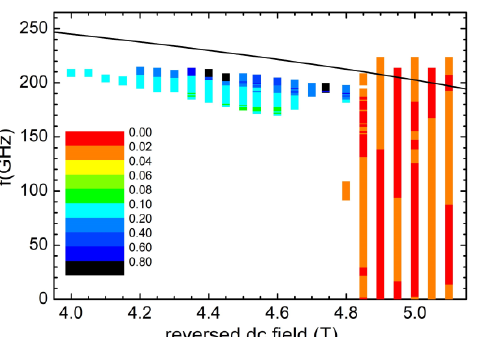
Figure 3. Conditions (exciting frequency vs. applied reversed field) under which reversal occurs within 1 ns for a CoPt disk with diameter 16 nm and thickness 4 nm, when the applied field is at 45° to the easy axis. The color code represents the switching time in nanoseconds. The solid black line represents the Kittel condition in this case.